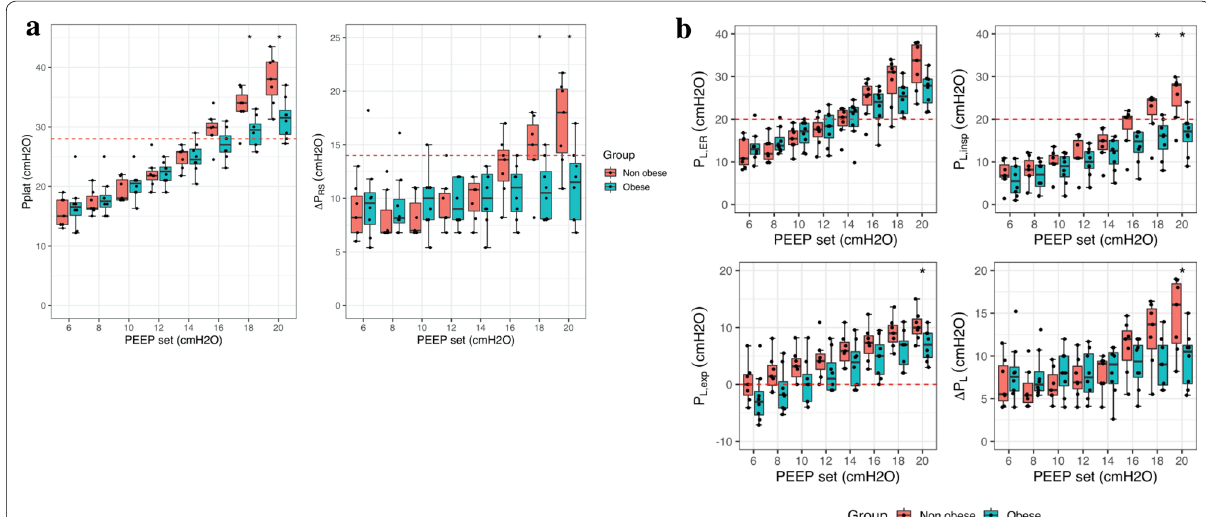
Fig. 1 a Boxplots of respiratory system plateau pressures (Pplat) according to set PEEP and group. Black dots represent individual values. Red dashed line denotes 28 cm H 2 O. * p < 0.05 between obese and non‑obese group for a given PEEP by Mann–Whitney U test. Boxplots of respiratory system driving pressures (∆P RS ) according to set PEEP and group. Black dots represent individual values. Red dashed line denotes 14 cm H 2 O. * p < 0.05 between obese and non‑obese group for a given PEEP by Mann–Whitney U test. b Boxplots of end‑inspiratory elastance‑ratio derived ( P L, ER ), end‑inspiratory absolute method ( P L, insp ) and end‑expiratory ( P L, exp ) transpulmonary pressures according to set PEEP and group. Black dots represent individual values. Red dashed lines denote 20 cm H 2 O for P L, ER and P L, insp plots, and 0 cm H 2 O for P L, exp plot. * p < 0.05 between obese